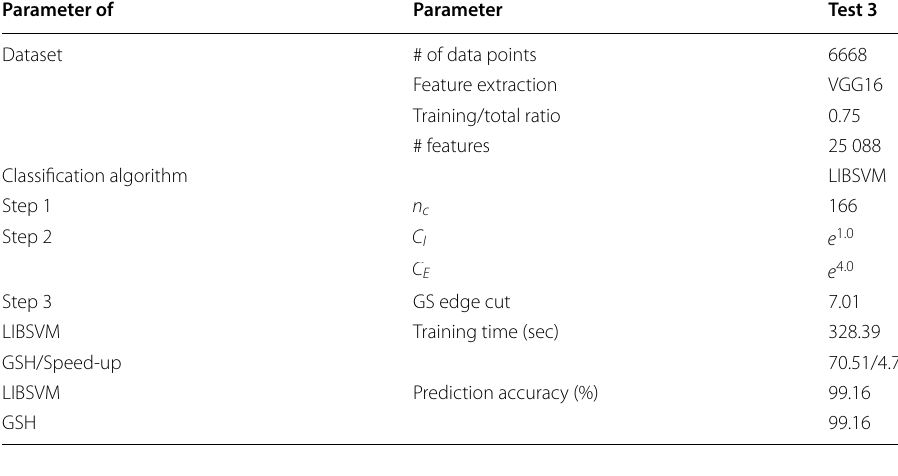
Table 8 Dataset V, and test 3 parameters Parameter of